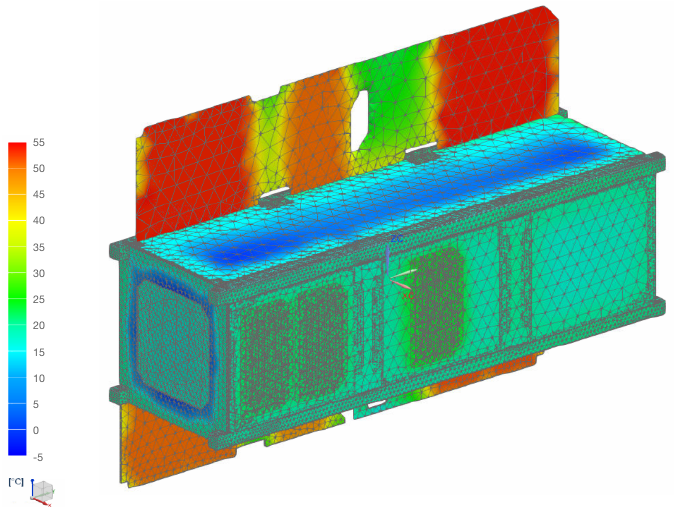
Figure 19. The satellite thermal analysis results after one orbit. In this specific case, the deployables are facing the sun. Maximum temperature is ∼ 53 ◦ C (red region) and minimum temperature is ∼ 0 ◦ C (blue region). Courtesy of Basel